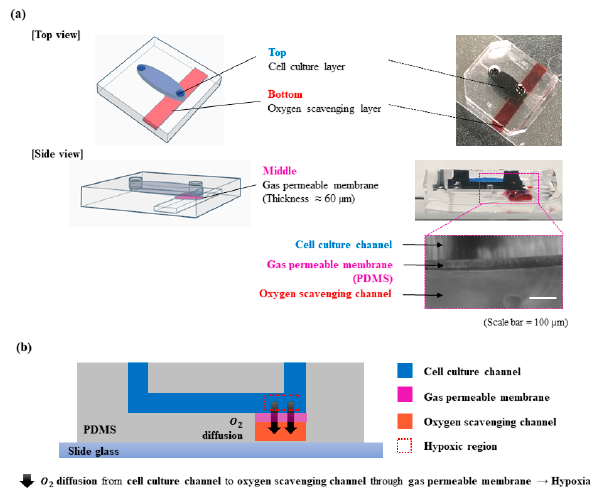
Figure 1. Schematic images of the designed microfluidic device capable of controlling oxygen level.